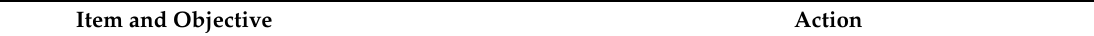
Table 2. Ensuring the continuity of essential antenatal and postnatal care services at the community level during the COVID-19